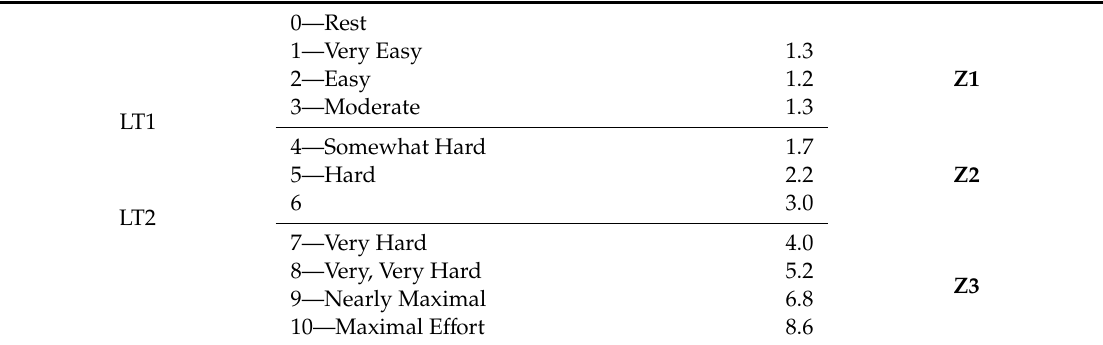
Table 2. Interpolated breakpoints on the session rating of perceived exertion (sRPE) scale in open water swimmers (OWS) corresponding to first rise /+ 2 mM of BLC.